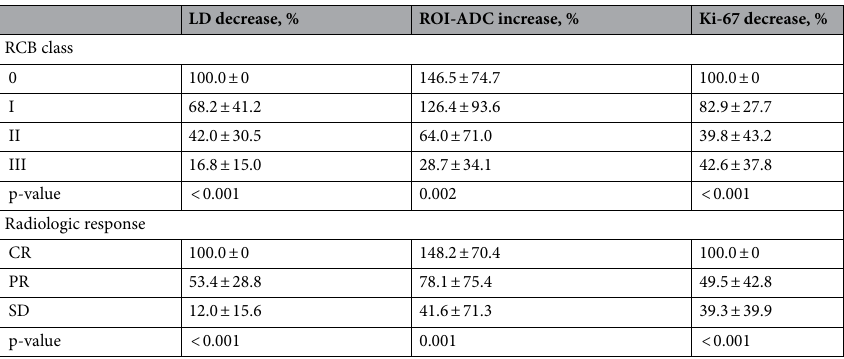
Table 4. Variations in LD and their effect on DCE MRI, ROI-ADC, and Ki-67 index after NACT according to radiologic response and RCB class. ADC apparent diffusion coefficient, CR complete response, DCE MRI dynamic contrast-enhanced magnetic resonance imaging, Ki-67 Ki-67 proliferation index, LD largest diameter, NACT neoadjuvant chemotherapy, PR partial response, RCB residual cancer burden, RECIST response evaluation criteria in solid tumors, used for evaluating radiologic response; ROI region of interest; SD stable disease.